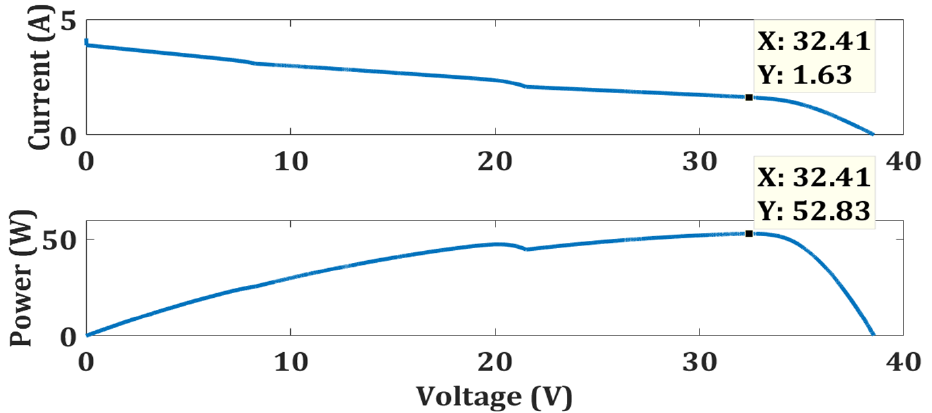
Figure 21. Characteristic curve of 3S PV system for test case 3 .